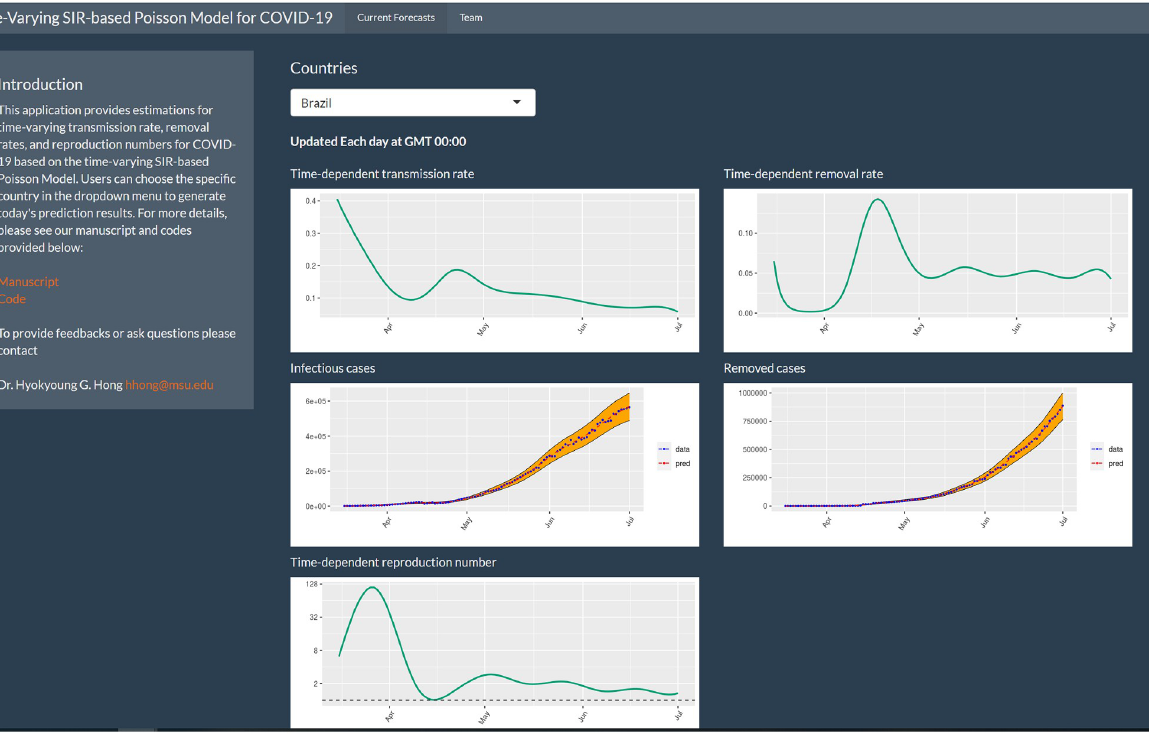
Fig 4. An illustration of the developed interactive web application.